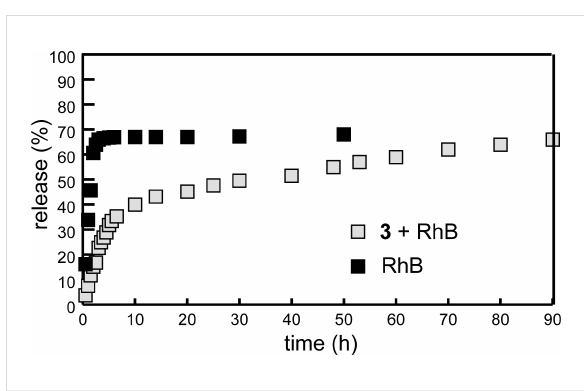
Figure 7: In vitro release pro fi les of free RhB and RhB-loaded micelles of 3 in PBS release medium at pH 7.4.